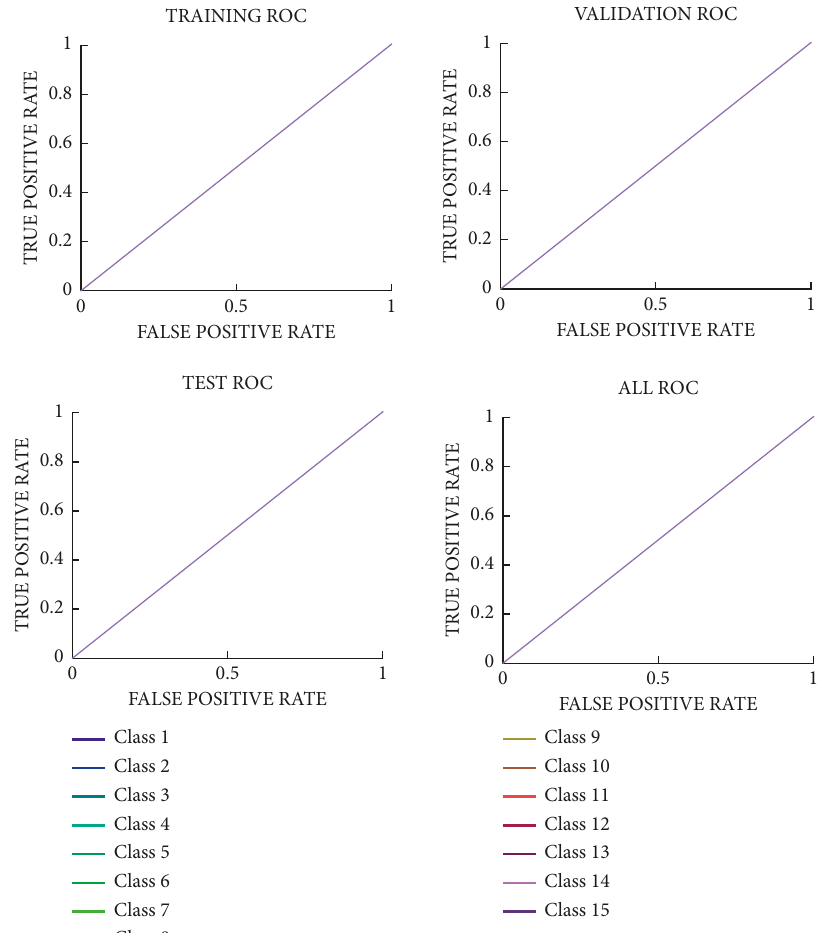
Figure 8: Receiver output characteristics graph for healthy-healthy image.